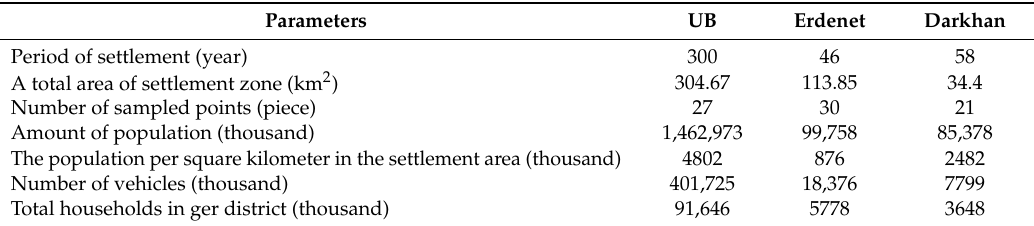
Table 1. Some information regarding the study